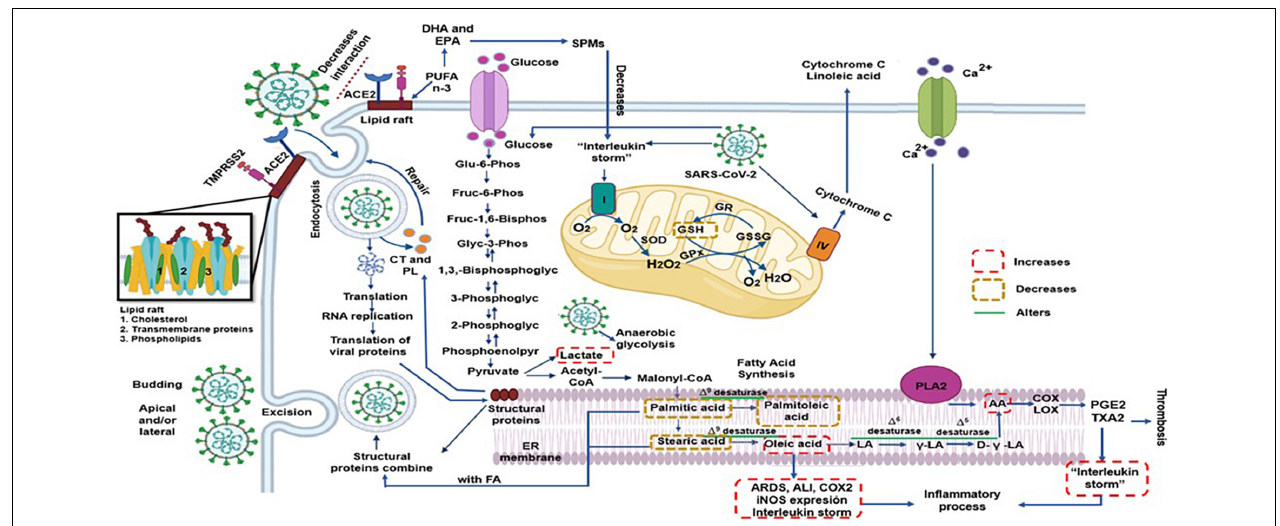
FIGURE 3 | The SARS-CoV-2 can modulate and rearrange the host lipid profile to reach an intricate homeostasis which is optimal for viral replication and propagation. However, any exogenous manipulation that disrupts this the equilibrium might interfere with the replication of the virus such as high EPA and DHA concentration that decrease pro-inflammatory state being precursor of SPMs to and probably the AA however this FA might have two effects; increase inflammatory and thrombotic prostaglandins that would aggravate the infection by SARS-CoV-2 and/or decrease viral replication and propagation. AA = arachidonic acid, ACE2 = angiotensin converting enzyme 2, COX = cyclooxygenase, CT = cholesterol, D- γ -LA = dihomo- γ -linolenic acid, DHA = docosahexaenoic acid, EPA = eicosapentaenoic acid, FA = Fatty Acid, GPx = glutathione peroxidase, GR = glutathione reductase, GSH = glutathione, GSSG = oxidized glutathione, H2O2 = hydrogen peroxide, LA = linoleic acid, LOX = lipoxygenase, O 2 = superoxide anion, PGE2 = prostaglandin E2, PL = phospholipids, PLA2 = phospholipase A 2 , PUFA = polyunsaturated fatty acids, SOD = superoxide dismutase, SPMs = specialized pro-resolving mediators, TXA2 = thromboxane A2, γ -LA = γ -linoleic